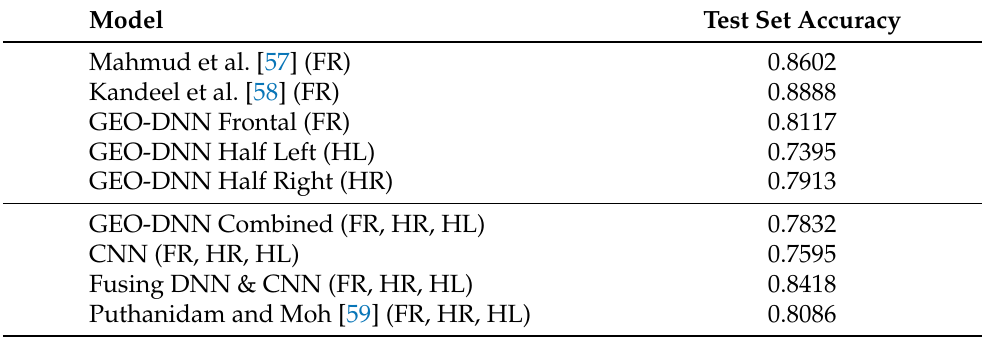
Table 5. The test set accuracy scores for the final DNN models (and their concatenated score) and the CNN. Included are three state-of-the-art scores on the KDEF